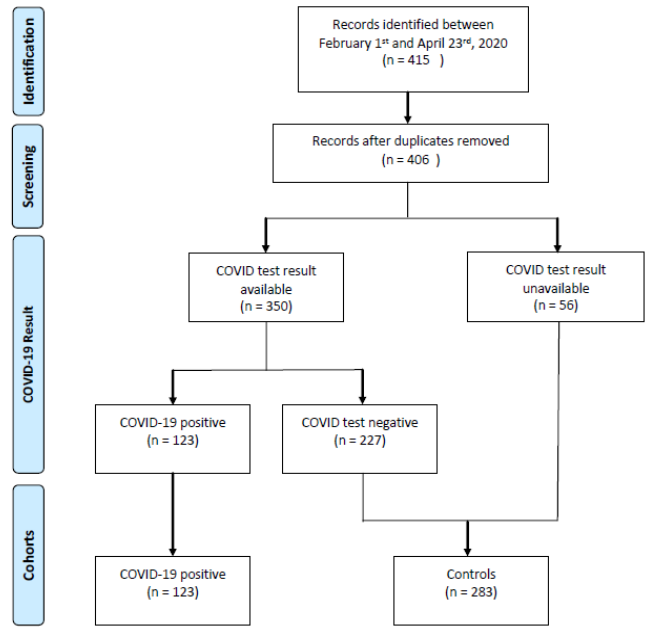
Figure 2. COVID-19-positive and control cohorts generated from procedure notes and COVID-19 test results collected from electronic health record intubation report between February 1–April 23, 2020.